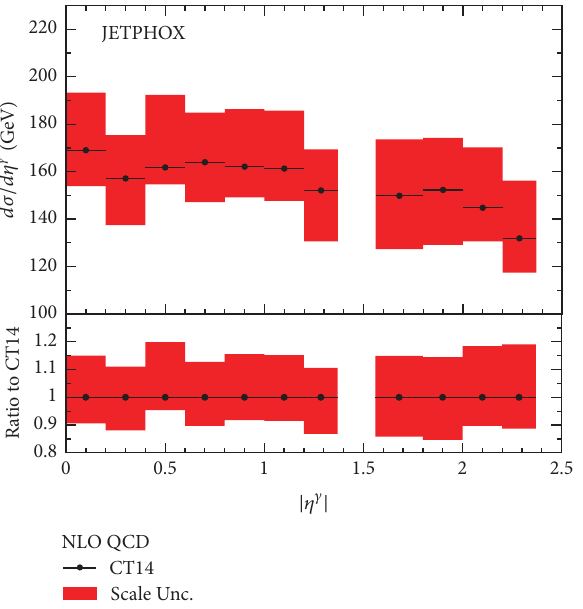
Figure 6: Same as Figure 5, but as a function of 𝜂 𝛾 .